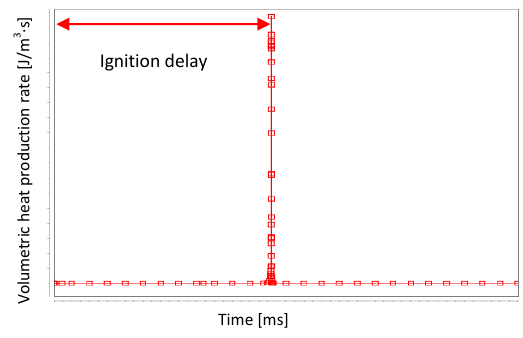
Fig. 18. Ignition delay determined in ANSYS Chemkin-Pro